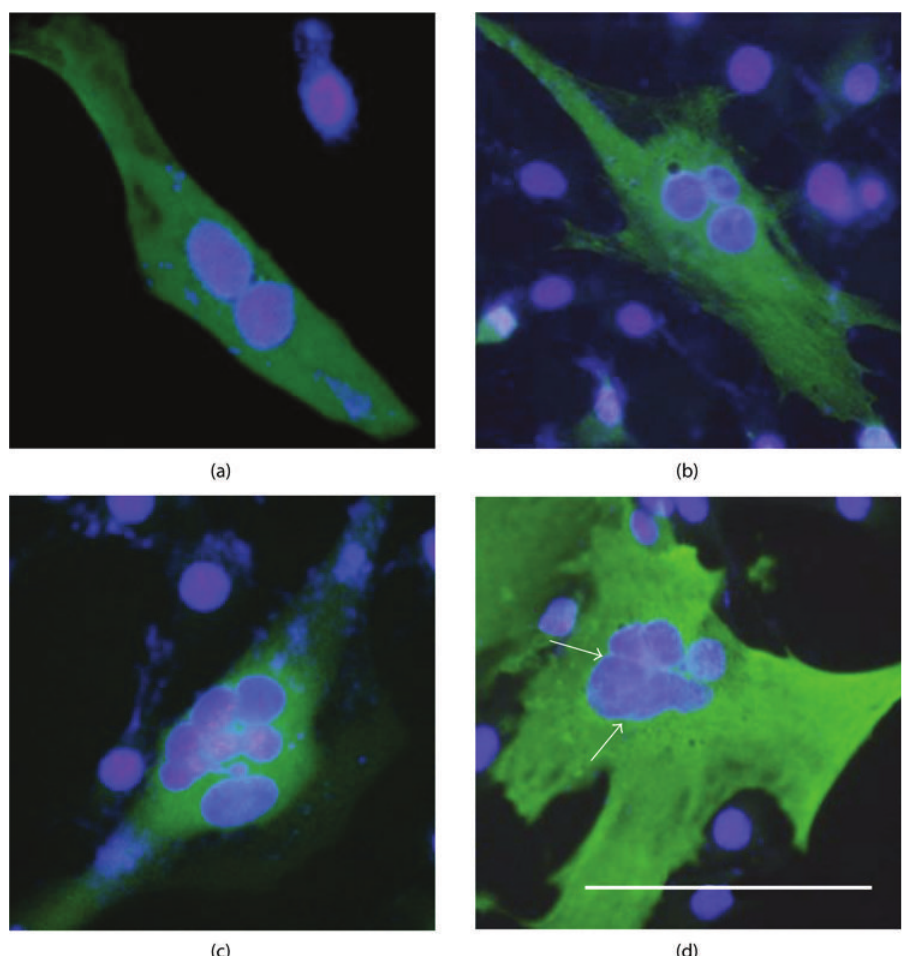
Figure 7: Formation of multinucleate cells in C2C12 cells transfected with the ha/mzyg1 fusion gene (HA/ZYG1). C2C12 cells were transfected with the ha/mzyg1 fusion gene, fixed with 4% paraformaldehyde, and stained by antibodies and DAPI according to the methods described in Section 2. The FITC images merged with DAPI images of large-sized HA/ZYG1 cells containing 2 nuclei (a), 3 nuclei (b), and 7 nuclei (c) are shown. Considering some gulfs observed in a nucleus, it is evident that a large nucleus is formed by nuclear fusion (d; arrows). Bar: 100 μ